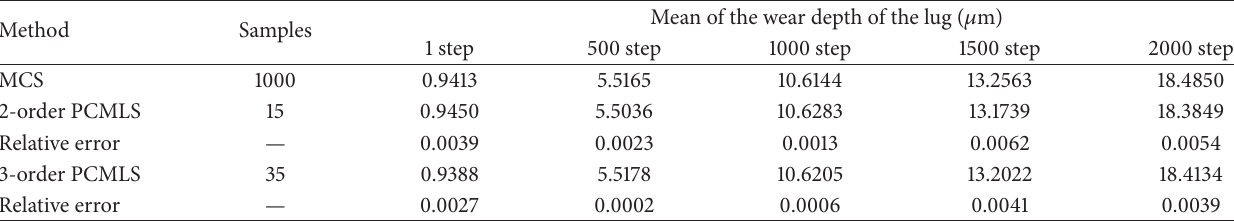
Table 3: Comparative results of mean of the wear depth of the lug along the time axis.